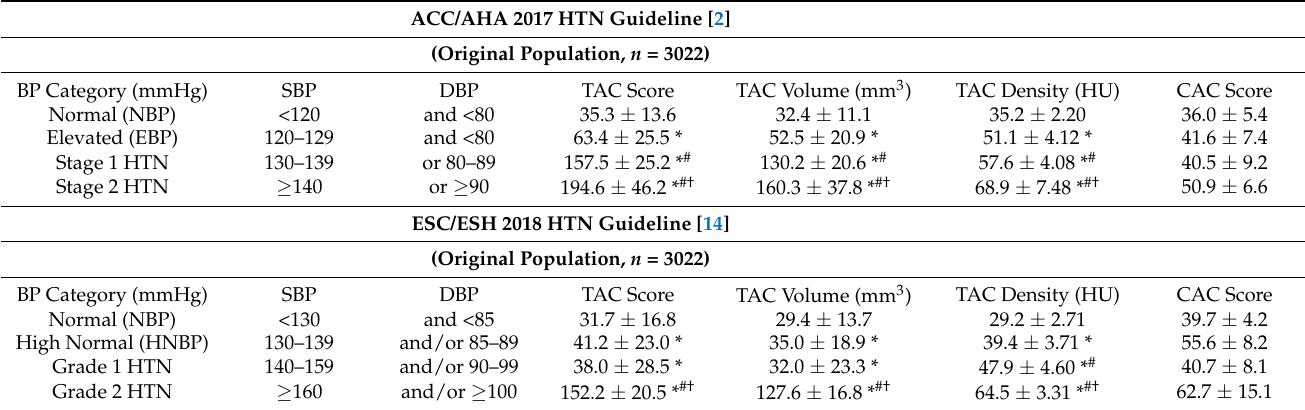
Table 2. Adjusted estimates of thoracic aortic calcification (TAC) burden from different measures across different stages/grades of HTN, using different clinical